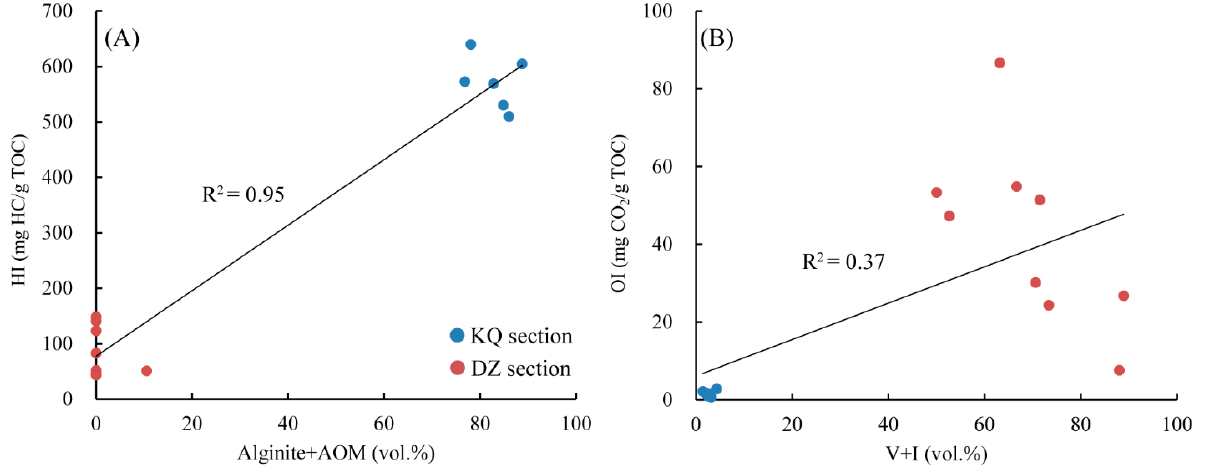
Figure 8. ( A ) Relationship between hydrogen index (HI) and alginite and amorphous organic matter (AOM) content; ( B ) relationship between oxygen index (OI) and vitrinite (V) and inertinite (I) con-